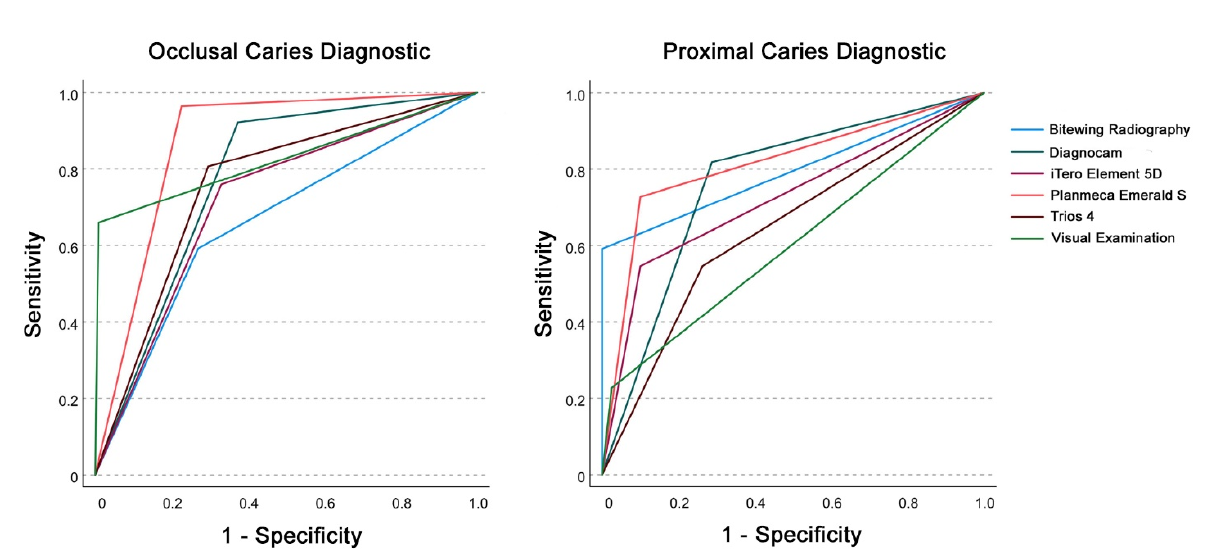
Figure 4. Receiver operating characteristic (ROC) curve analysis for occlusal ( left ) and proximal ( right ) caries diagnostics for the investigated diagnostic methods in permanent teeth with threshold I (sound (0)) versus overall caries (pooled data of enamel (1) and dentin caries (2)).